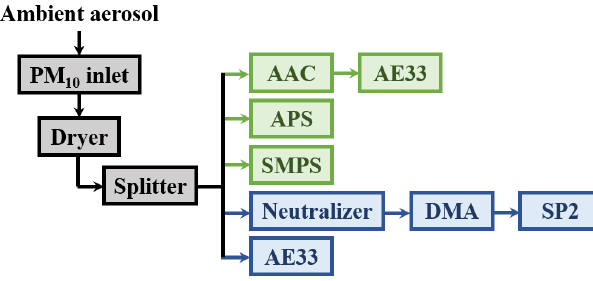
Figure 1. Schematic diagram of the measurement (green) and the validation (blue)